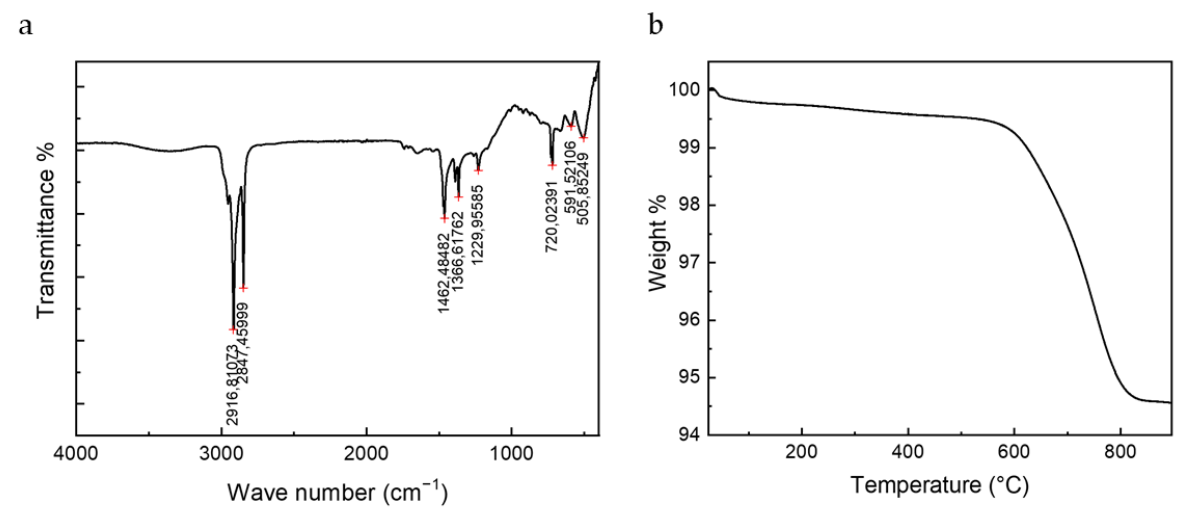
Figure A2. ( a ) FTIR spectrum of NTP and ( b ) TGA curve.